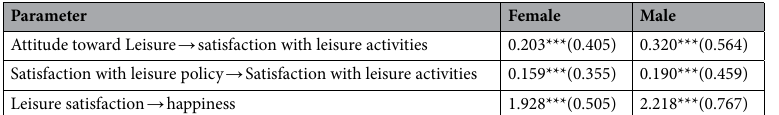
Table 5. Parameter estimates for female and male Groups (model with equality constraint on factor loading). Parameter estimates are unstandardized coefficients. Standardized coefficients are given in parentheses. *** p <